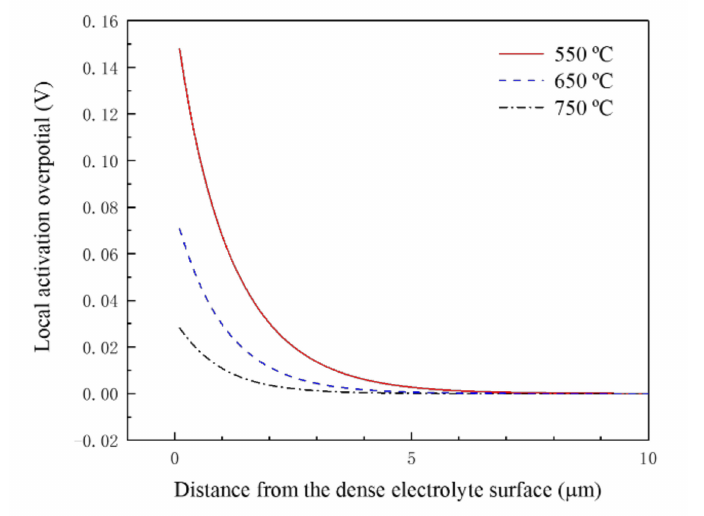
Figure 3. The local activation overpotential distribution η c,1